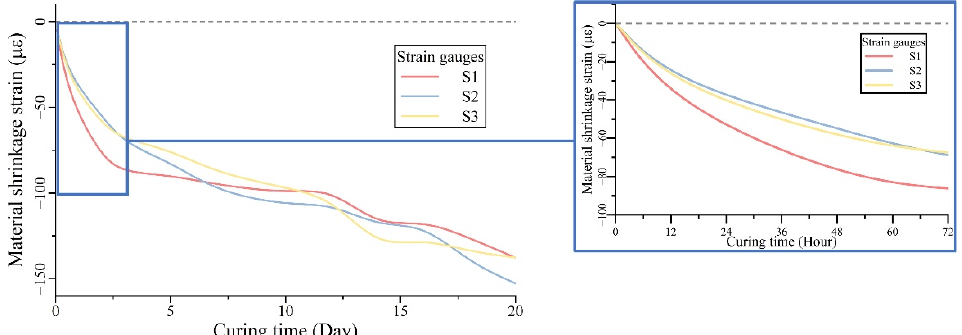
Figure 5. Experimental result of material shrinkage strain in UHPC composite deck.